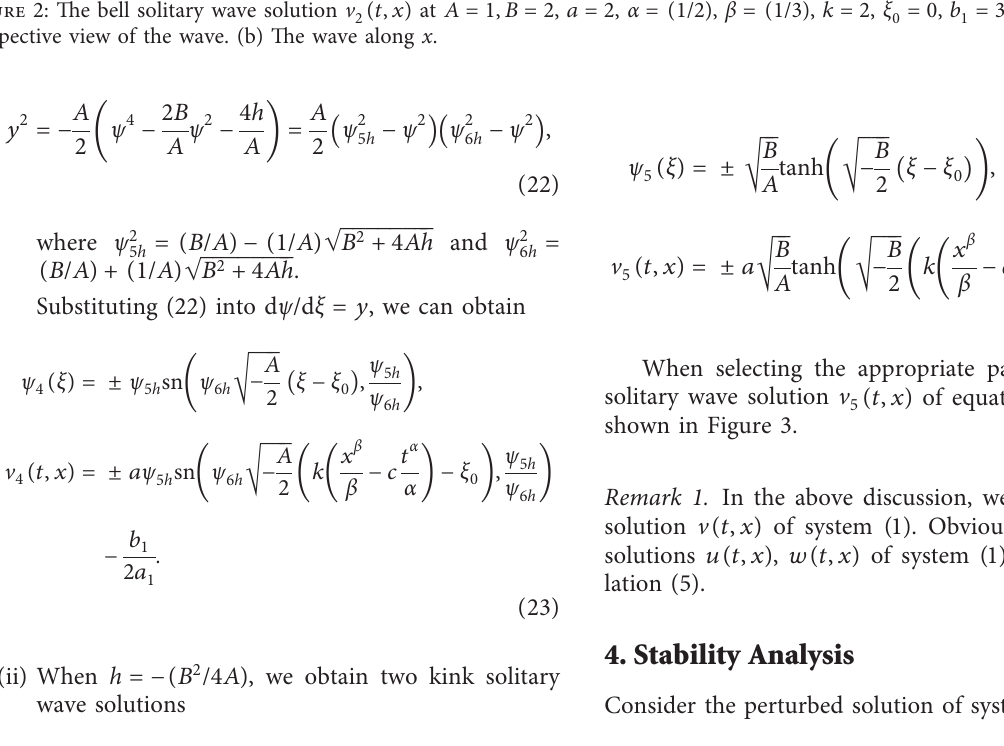
� 0, b � 3, c � 1, and c � 2 (a) 0 1 1